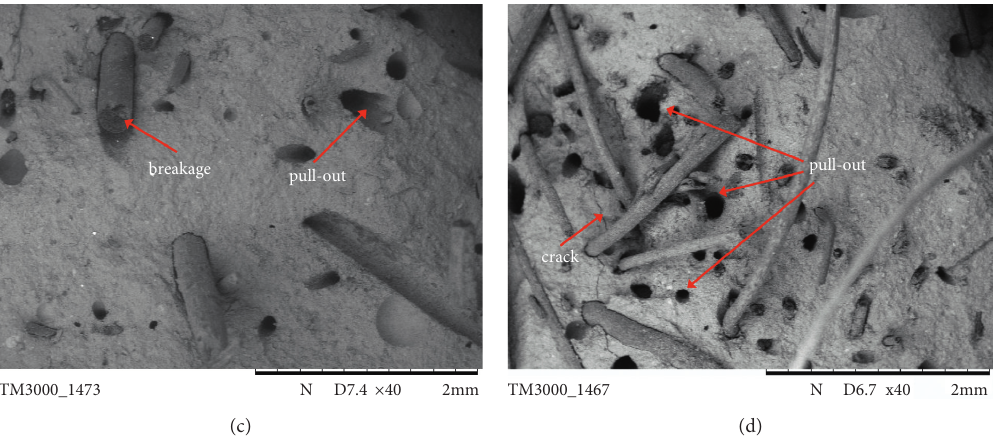
Figure 5: SEM observation of the fracture surface of samples: (a) without CNS and with (b) 2%, (c) 4%, and (d) 6% CNS.